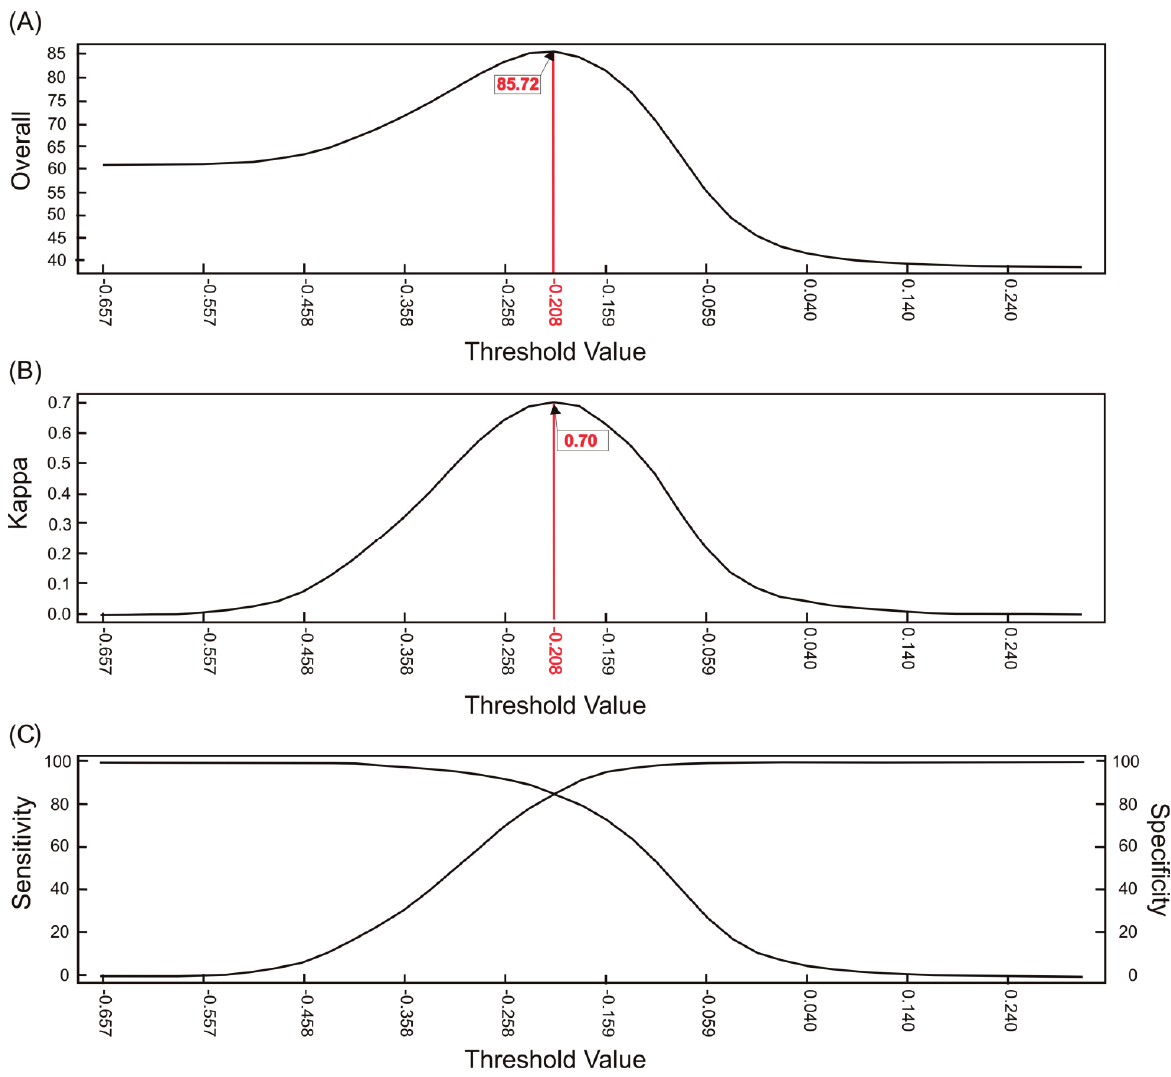
Figure 19. Identification of the optimal threshold values for burned-area detection from the deviation images using seasonal differencing. The accuracy assessment curves refer to